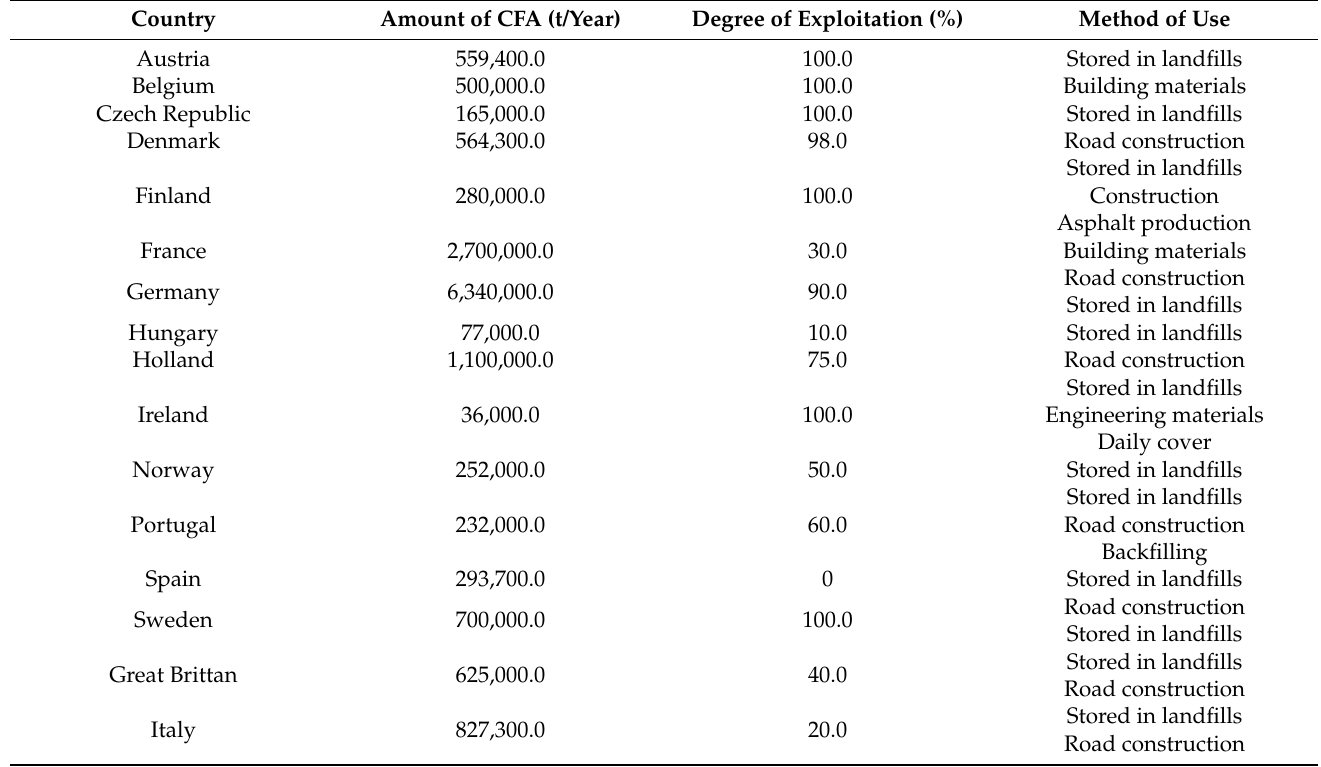
Table 7. Handling of slag and ash for the thermal treatment of waste in selected EU countries. Source: [74,85,86]. Country Amount of CFA